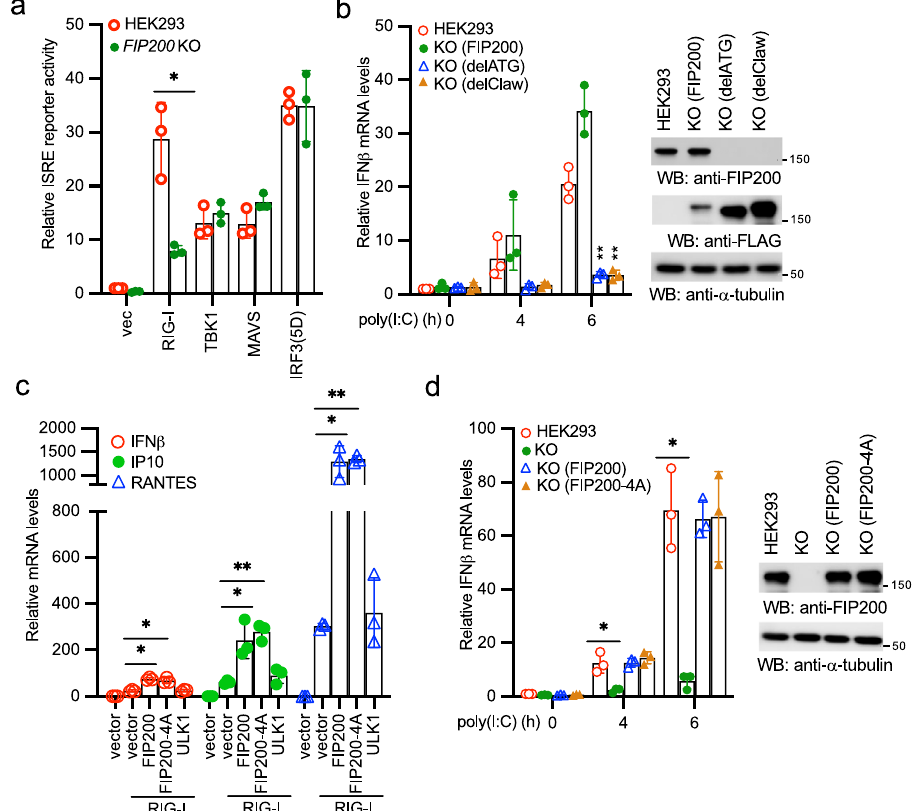
Fig. 5 FIP200 activates innate immunity via RIG-I but independently of its autophagy function. a FIP200 wild type and knockout HEK293 cells were transfected with vector, RIG-I, TBK1, MAVS, or IRF3(5D) together with pRL-SV40 and pISRE-Luc. After 48 h, cells were collected and the ratio of fi re fl y luciferase to Renilla luciferase was calculated to determine the relative activity of IFN reporter. All experiments were biologically repeated three times. Data represent means ± s.d. of three independent experiments. The P -value was calculated (two-tailed Student ’ s t test) by comparison with HEK293 cells. * P < 0.05. b Wild-type HEK293 cells, FIP200 knockout cells reconstituted with full-length FIP200, delATG, or delClaw were stimulated with 1 μ g ml − 1 poly(I:C) for designated times. Then, RNA was extracted, and real-time PCR for IFN β was performed. All experiments were biologically repeated three times. Data represent means ± s.d. of three independent experiments. (** P < 0.01 vs. the wild-type cells by two-tailed Student ’ s t test). Right panel shows the expression of FIP200 and the mutants in the reconstituted cells. The anti-FIP200 antibody detects the C-terminal end of FIP200 and cannot recognize delATG and delClaw. c RIG-I was transfected with vector, FIP200, FIP200-4A, or ULK1 into HEK293 cells. After 48 h, RNA was extracted, and real-time PCR assays for IFN β , IP10, and RANTES were performed. All experiments were biologically repeated three times. Data represent means ± s.d. of three independent experiments. (* P < 0.05, ** P < 0.01, by two-tailed Student ’ s t test). d Wild-type HEK293 cells, FIP200 knockout cells, and FIP200 knockout cells reconstituted with full-length FIP200 or the 4A mutant were stimulated with 1 μ g ml − 1 poly(I:C) for designated times. Then, RNA was extracted, and real-time PCR for IFN β was performed. All experiments were biologically repeated three times. Data represent means ± s.d. of three